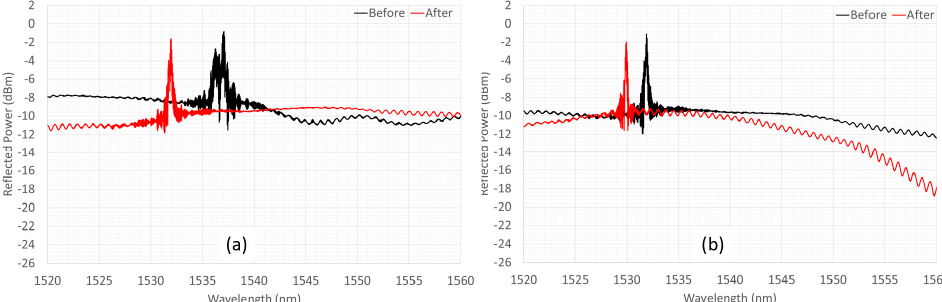
Figure 13. Grating spectrum evolution after heating-cooling cycling, from RT to: ( a ) 750 °C and ( b ) 800 °C.